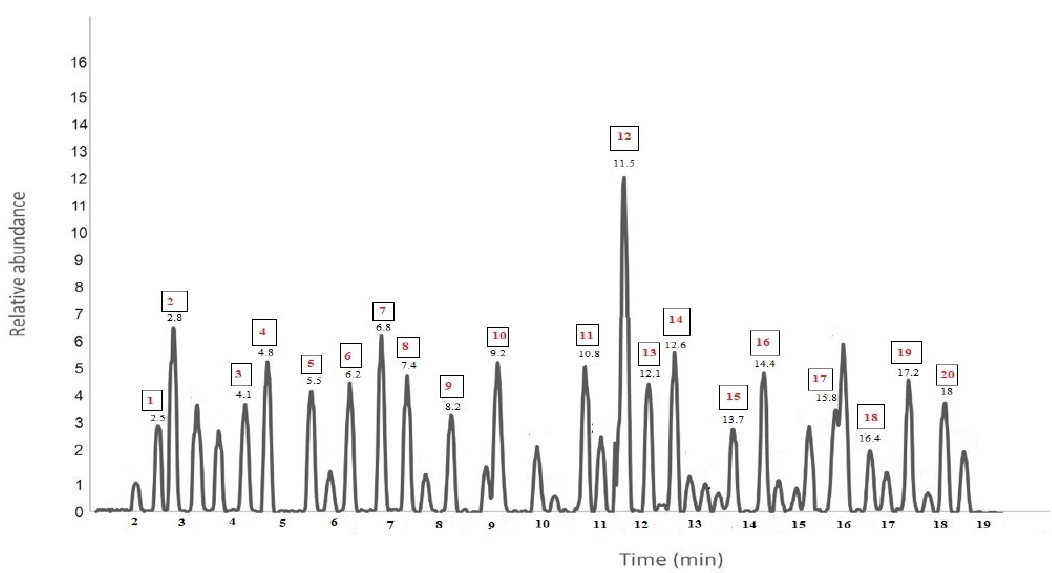
Figure 5. The extraction efficiency of DESs compared with water solvents. ( a ) TPC, ( b ) TFC. Both DES2: Tailor and DES3: CHGl extracts of R. officinalis were analysed and profiled by LC-MS/MS analysis in order to characterise the chemical constituents in R. officinalis qualitatively. To our knowledge, this is the first validated method for detecting active compounds in R. officinalis whole plant extracts using these kinds of DESs through LC- MS/MS analysis. The base peak chromatogram is depicted in Figures 6 and 7. Compounds were characterized by their retention times, the absorption spectrum in the UV-vis region, the mass spectrum obtained by MS-ESI and the fragmentation profile; these properties were compared with those mentioned in previous reports [31]. The results obtained from the LC-MS/MS analysis allowed the tentative assignment of many chemical constituents, and the same observations were shown by [37]. The compounds identified are listed in Tables 5 and 6. Table 5. Tentative identification of chemical constituents in the R. officinalis extract was obtained using DES2: Tailor.